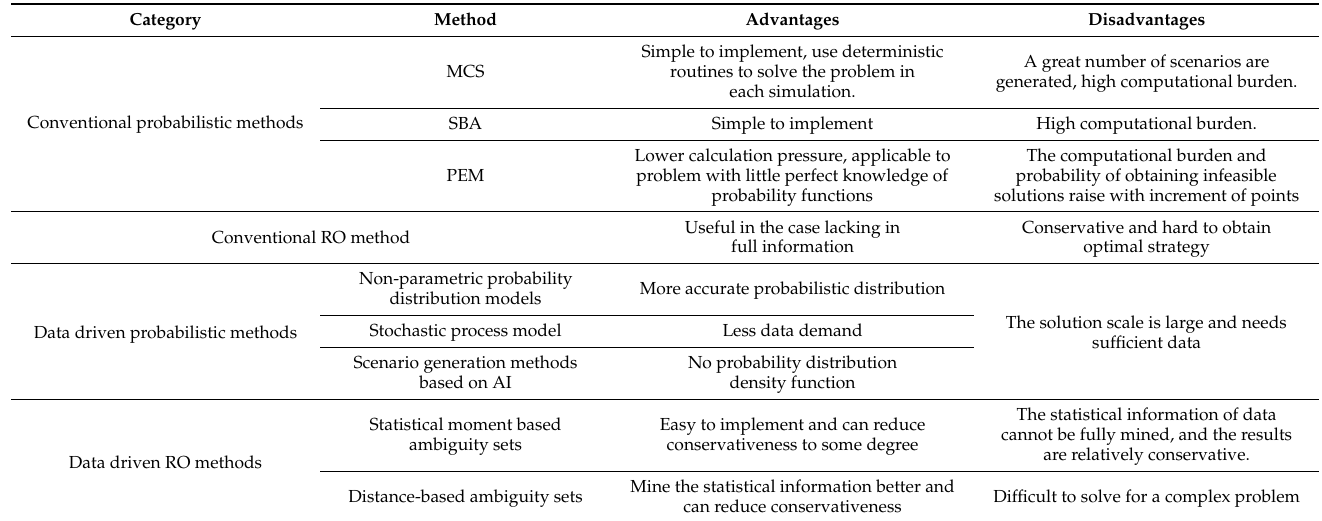
Table 2. Comparisons of uncertainty modeling